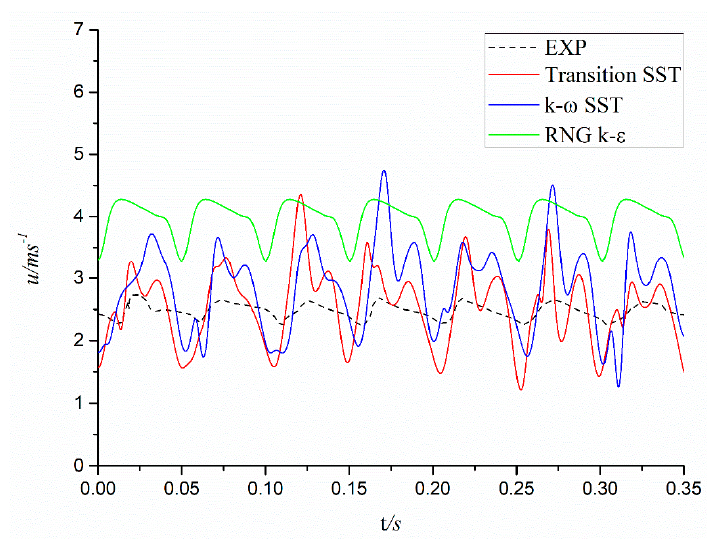
Figure 6. Time history of instantaneous velocity calculated by different turbulence model and experimental results at x/c = 2, y/Ls = 0.25, f = 20 Hz.